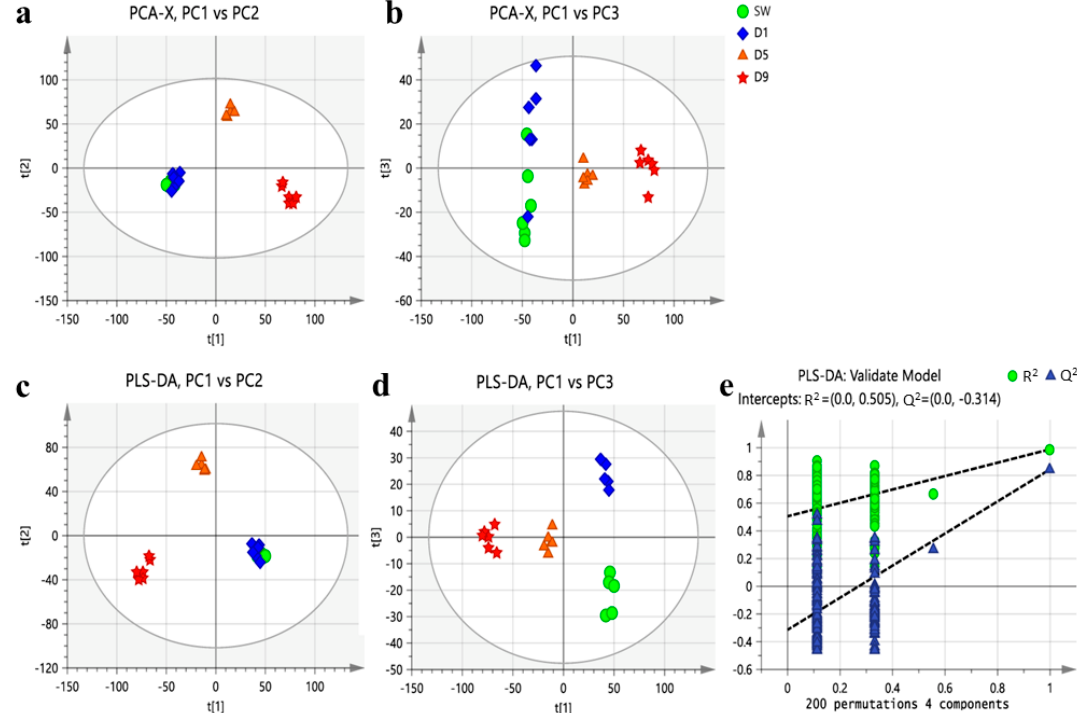
Figure 3. Scores plot of the principal component analysis (PCA) and partial least squares discrimination analysis (PLS-DA) of B. batryticatus from different stiff time. ( a ) PCA score plot (PC1 vs. PC2); ( b ) PCA score plot (PC1 vs. PC3); ( c ) PLS-DA score plot (PC1 vs. PC2); ( d ) PLS-DA score plot (PC1 vs. PC3); ( e ) presentation of chance permutation at 200 times used for the discrimination between the four groups [R 2 = (0.0, 0.505), Q 2 = (0.0, − 0.314)].